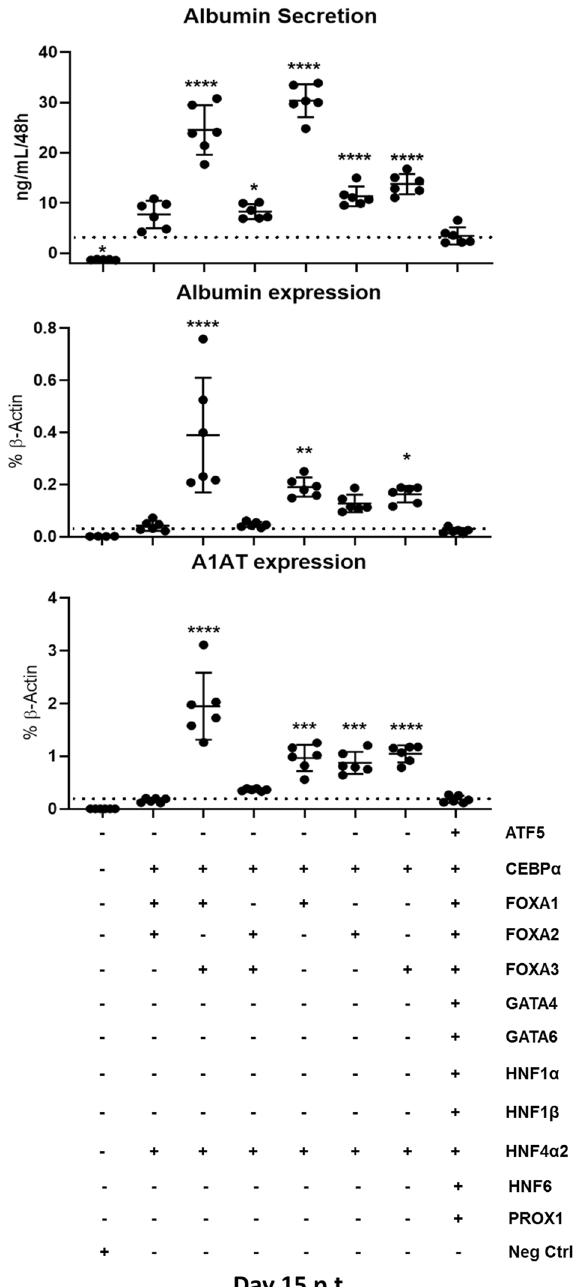
Figure 4. Third step of transcription factor screening in PKFs. Albumin secretion (upper panel), ALBUMIN and A1AT gene expression levels (medium and lower panel, respectively) in PKFs transduced with CEBPα and HNF4α2 (2TFs) plus different combinations of FOXAs transcription factor family. All data were analyzed using one-way ANOVA, with Tukey’s post-test. Significance from n = 6 independent values is displayed as *p < 0.05; ****p ≤